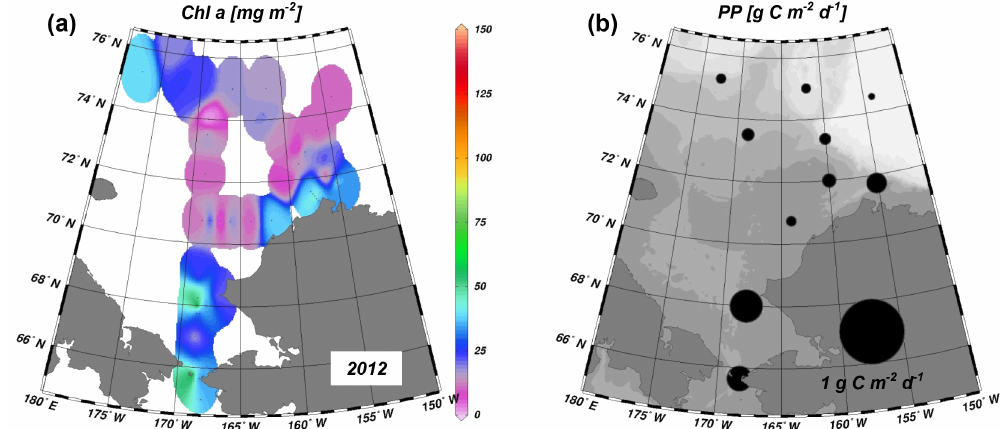
Figure 3. (a) Chlorophyll a integrated over the water column (mgm − 2 ) and (b) daily primary productivity in the water column (gC m − 2 d − 1 ) obtained from the 2012 R/V Mirai cruise.